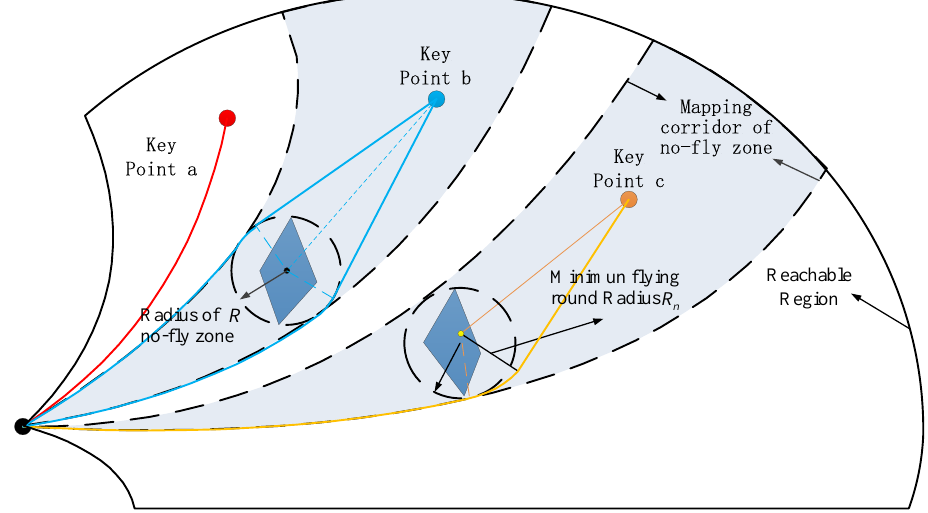
Figure 4. Association Model between strategic places and trajectories